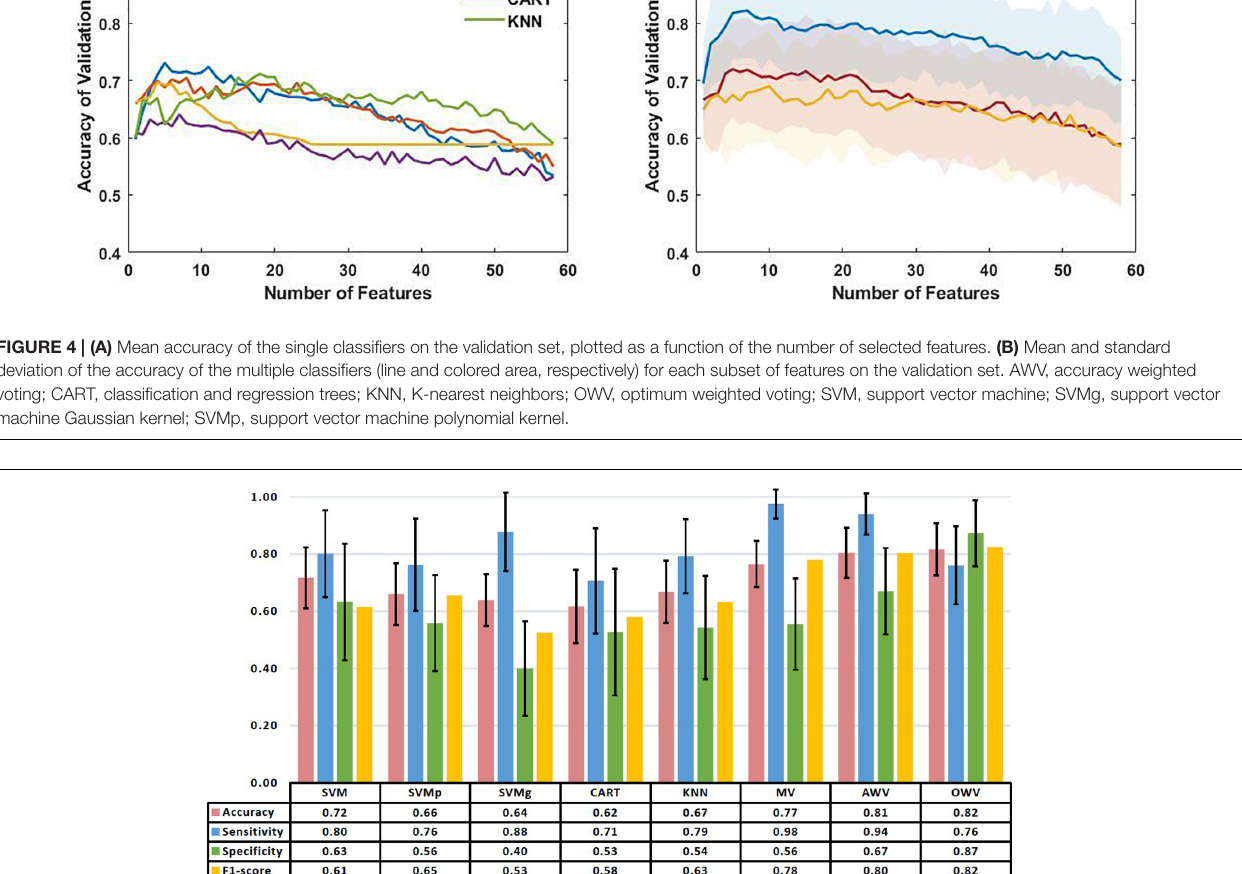
Frontiers in Physiology |